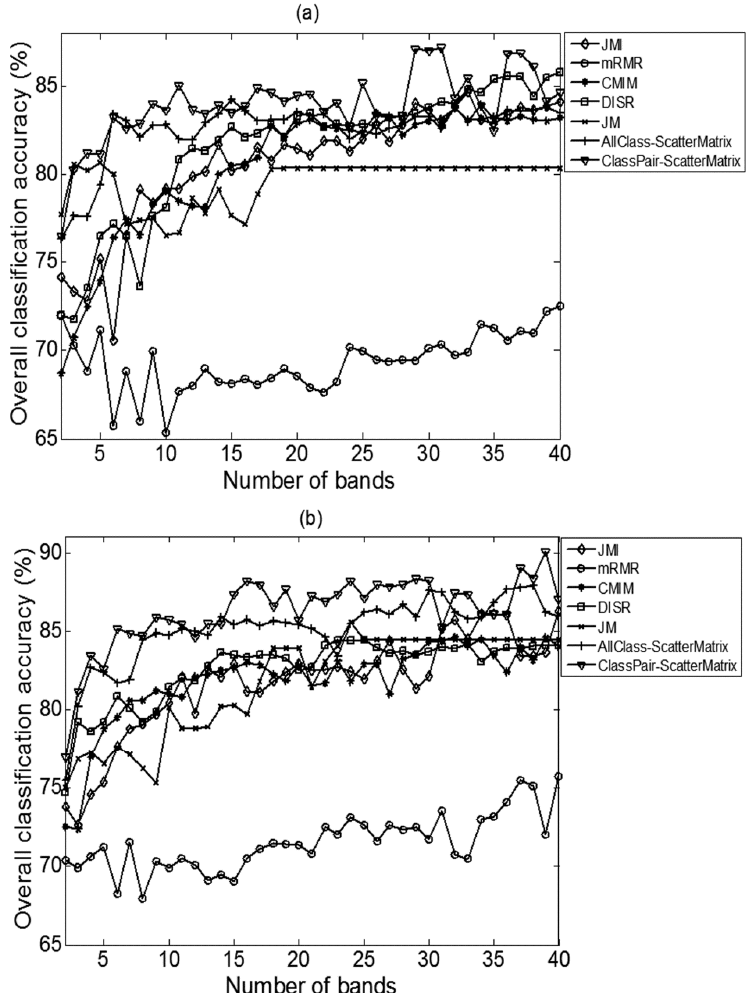
Figure 4. Overall classification accuracies of each method versus the number of selected bands